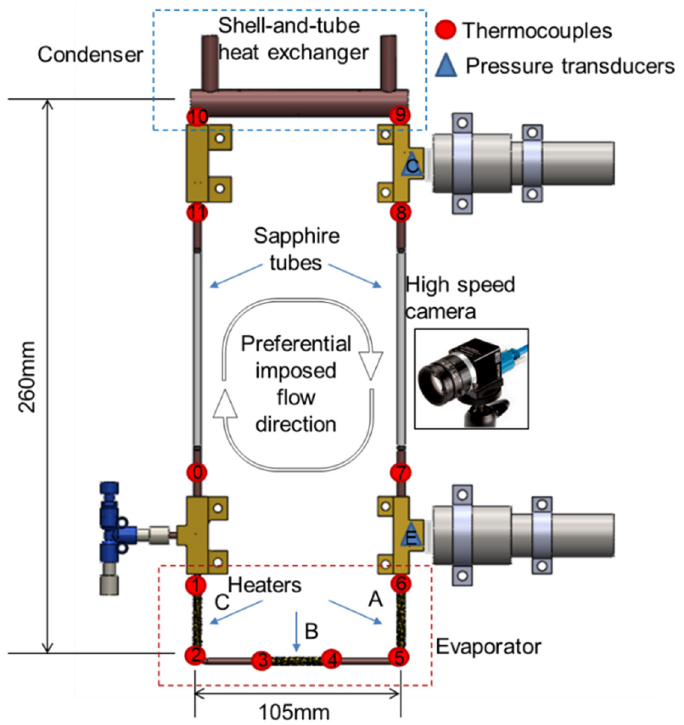
Figure 2. Rendering of the single-loop PHP with position of sensors and camera [45]. Reproduced with permissions Table 3. Experimental matrix with controlled parameters and parameters observed.